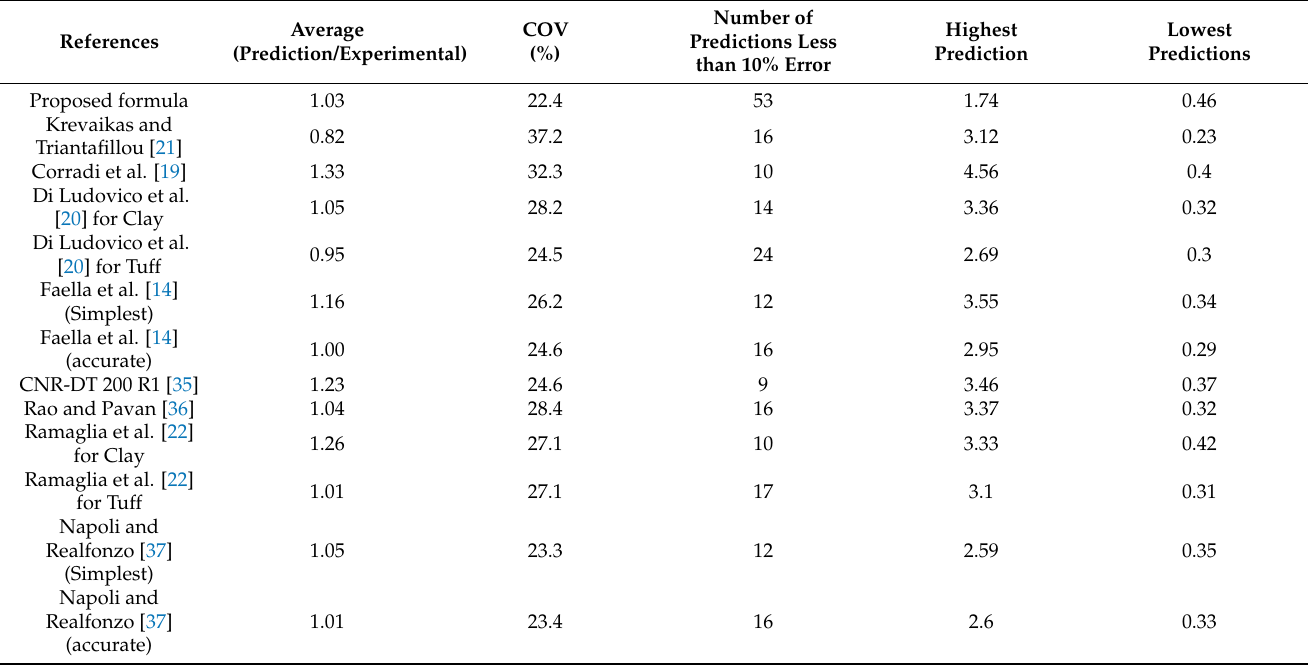
Table 8. Statistical analysis of FRP confined concrete prisms